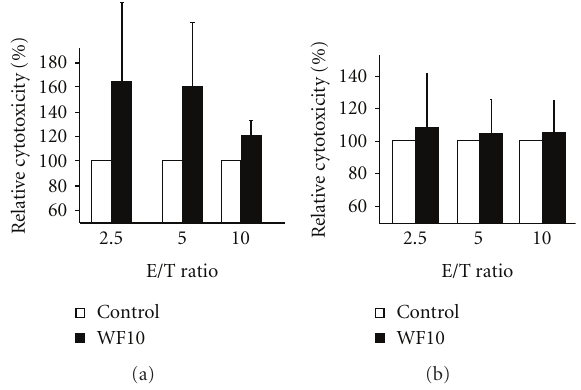
Figure 2: WF10 specifically a ff ects NK cells. (a) Freshly isolated resting human NK cells were preincubated for 5h with or without 200 μ M WF10 in culture medium, washed and then used in a standard 4h 51 Cr-release assays against LCL721.221 target cells at the indicated e ff ector to target (E/T) ratios. (b) LCL721.221 target cells were preincubated with or without 200 μ M WF10 in culture medium, washed and then used as targets in a standard 4 h 51 Cr- release assaysusing freshly isolated human NK cells as e ff ectors. The activity of the WF10-treated cells is shown relative to the cytotoxic activity of control cells (set as 100%) as an average value from (a) 4 or (b) 3 independent experiments.